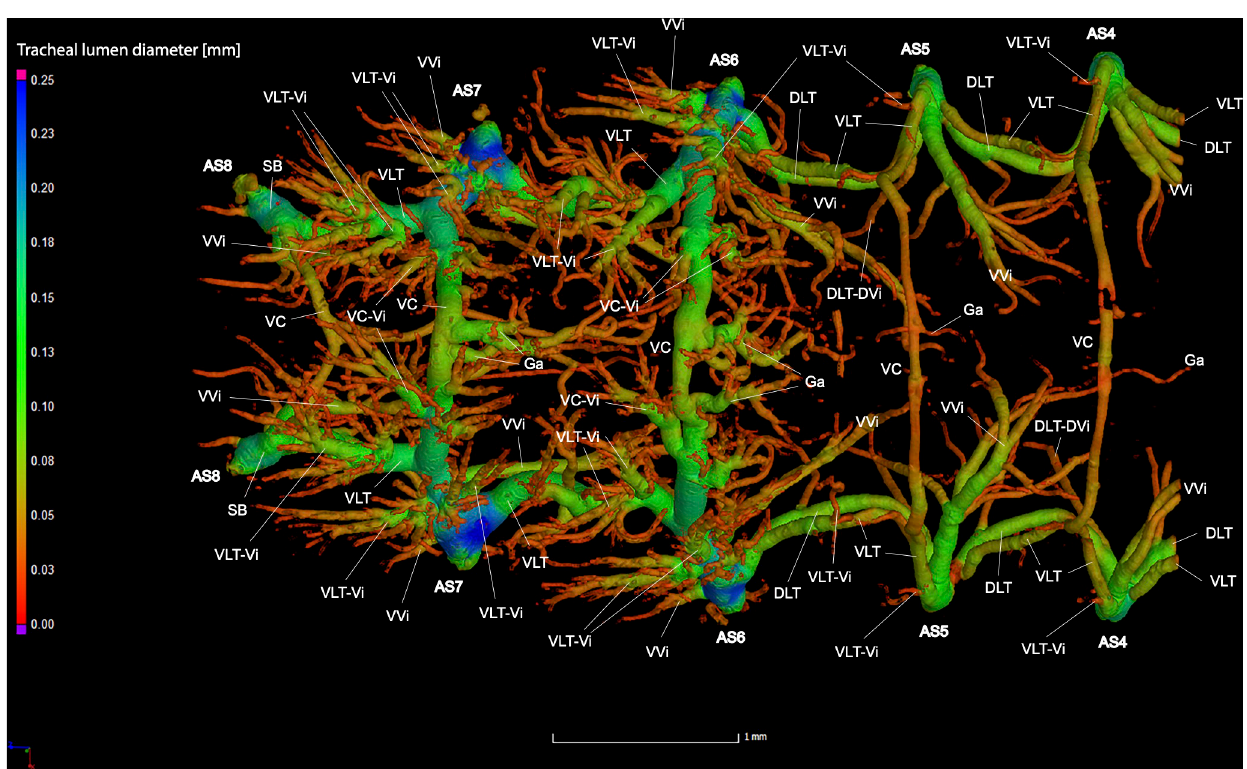
Fig 13. Lateral view of the abdominal tracheal system in adult male Photinus pyralis with smaller tracheae digitally removed.